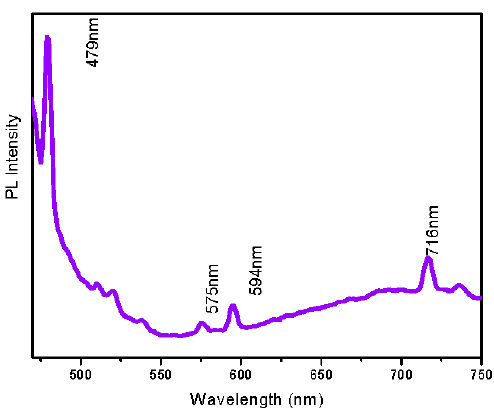
Figure 7. Photoluminescence spectrum of the CeO 2 -ZnO nanocomposite.